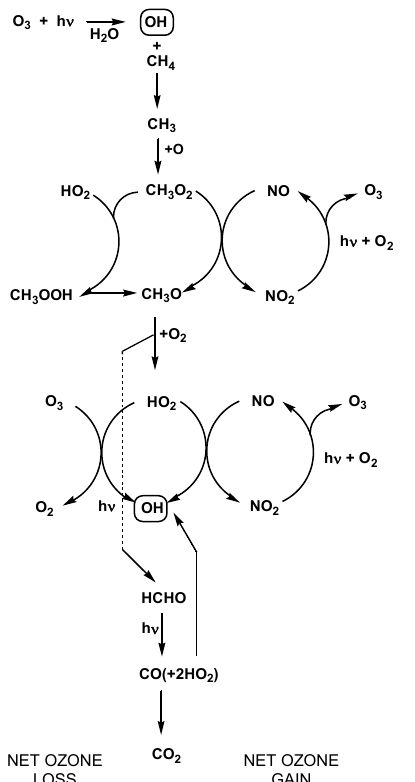
Figure 3. Simplified mechanism for the photochemical oxidation of CH 4 in the troposphere (Lightfoot et al., 1992).